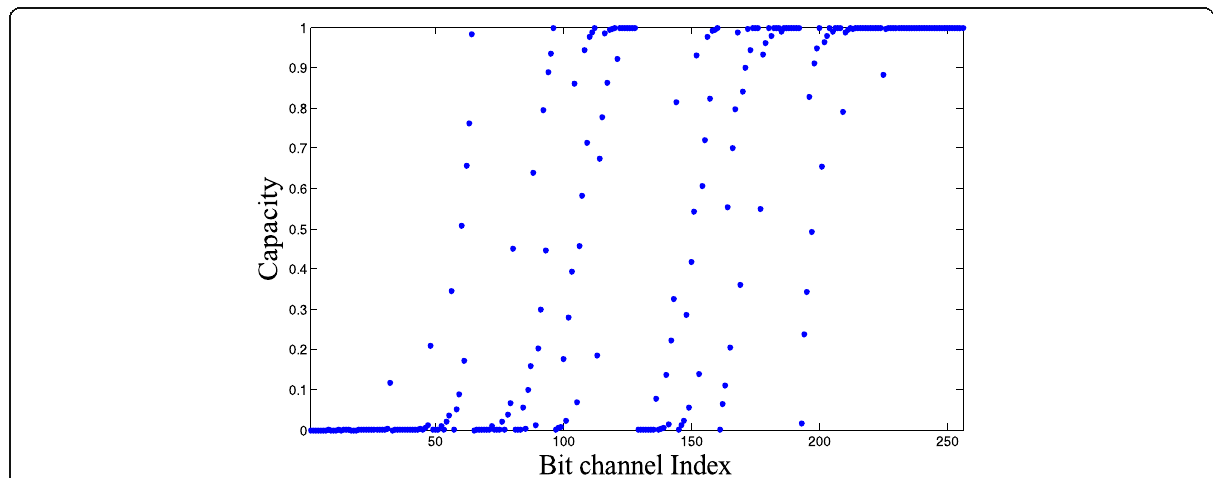
Fig. 4 The capacity of bit channel at N = 256: The capacity of binary erasure channels (BEC) when the code length N is 256